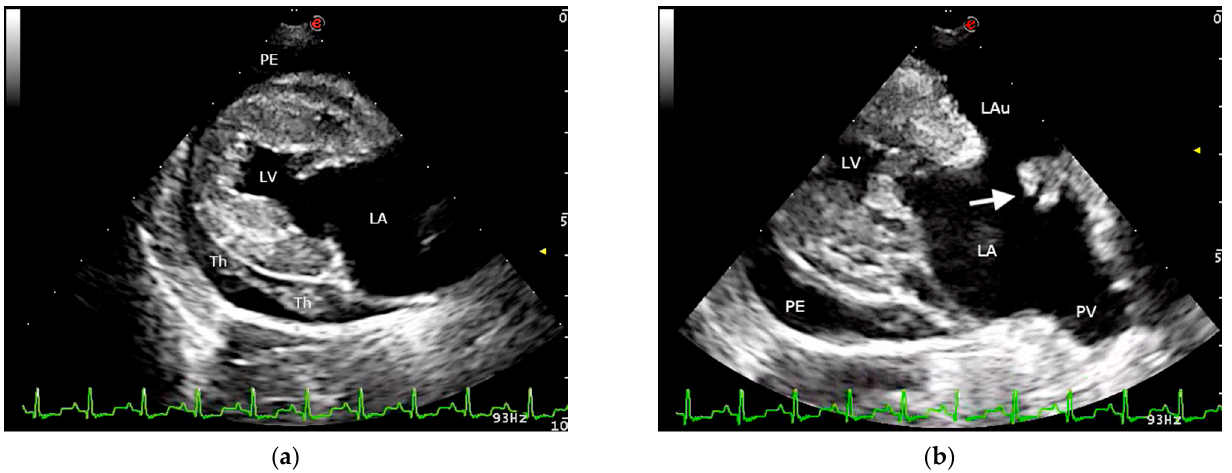
Figure 1. Conventional echocardiography at the presentation: ( a ) Right parasternal long-axis view showing pericardial effusion (PE) with hyperechoic density suggestive of a thrombus (Th). ( b ) Modified left parasternal long-axis view optimized to visualize the left atrium (LA) and auricle (LAu). A hyperechoic structure (arrow), adherent to the left atrial wall and consistent with a thrombus, is evident. LV, left ventricle; PV, pulmonary vein.